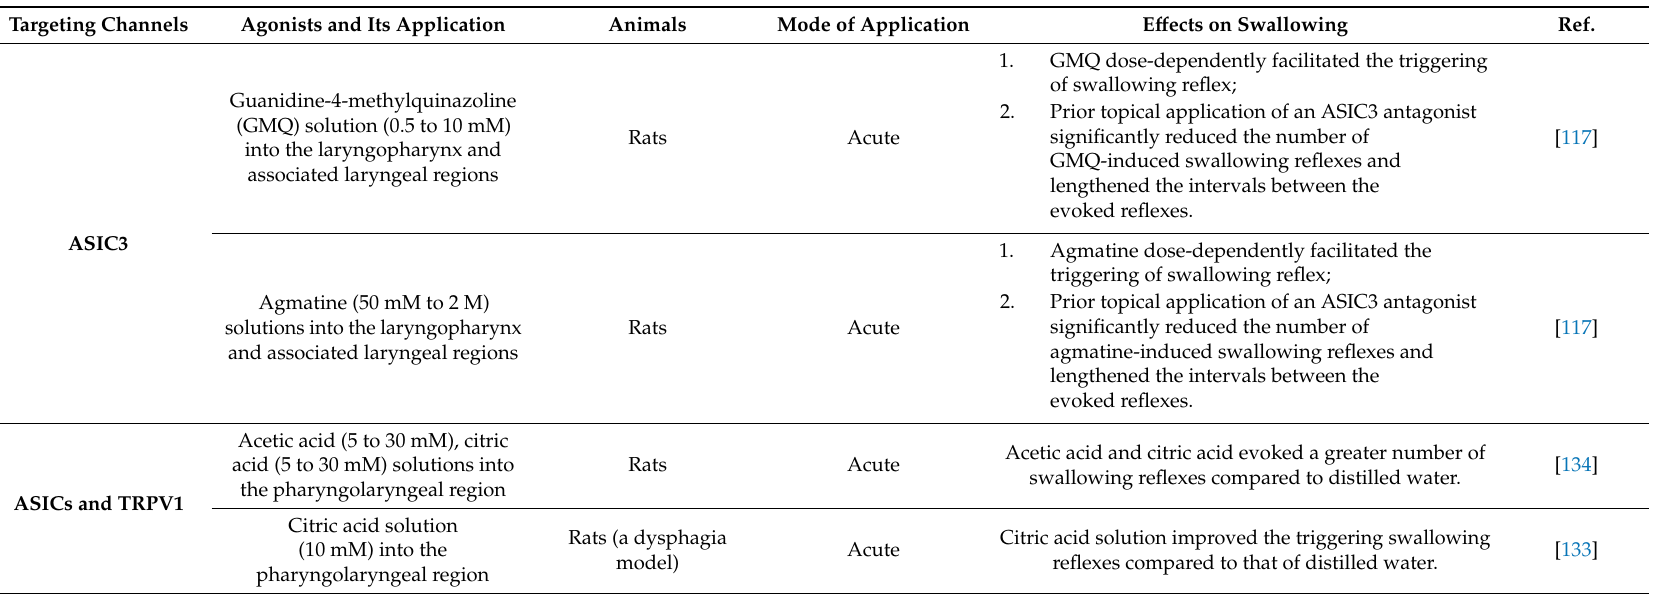
Table 2. Animal studies investigating the e ff ects of targeting chemosensory ion channels on